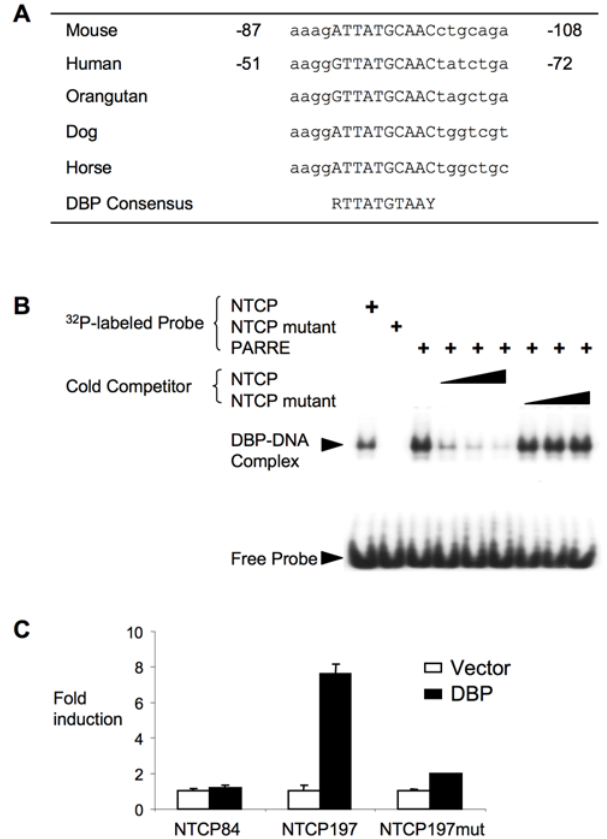
Figure 7. Analysis of circadian regulation of mouse NTCP promoter. A. Sequence alignment of conserved DBP binding site in NTCP promoter region of 2 87 to 2 108. R=A or G, Y=C or T in the consensus sequence. B. Gel-shift analysis of DBP binding to DBP putative DBP binding site from the NTCP promoter. Assays were performed with radiolabeled probes containing wild type (NTCP) or mutant (NTCP-mut) DBP binding site. The probe containing high affinity DBP binding consensus sequence (PARRE) was used as positive control. For the competition experiment, cold competitors in excess of 5, 10 and 25 folds were added. Protein-DNA complexes and free probes were indicated by arrowheads. C. Luciferase assay of mouse NTCP promoter constructs with the native and mutated, and without the DBP binding site. NTCP84 contains the region from 2 84 bp to + 37 bp (relative to the transcription starting site), NTCP197 encompass the regions of 2 197 bp to + 37 bp and 2 1 kb to + 37 bp respectively. NTCP197mut was generated by changing 3 nucleotides of the putative DBP binding site (from ATTATGCAAC to AT GGG GCAAC) in the NTCP197 reporter.